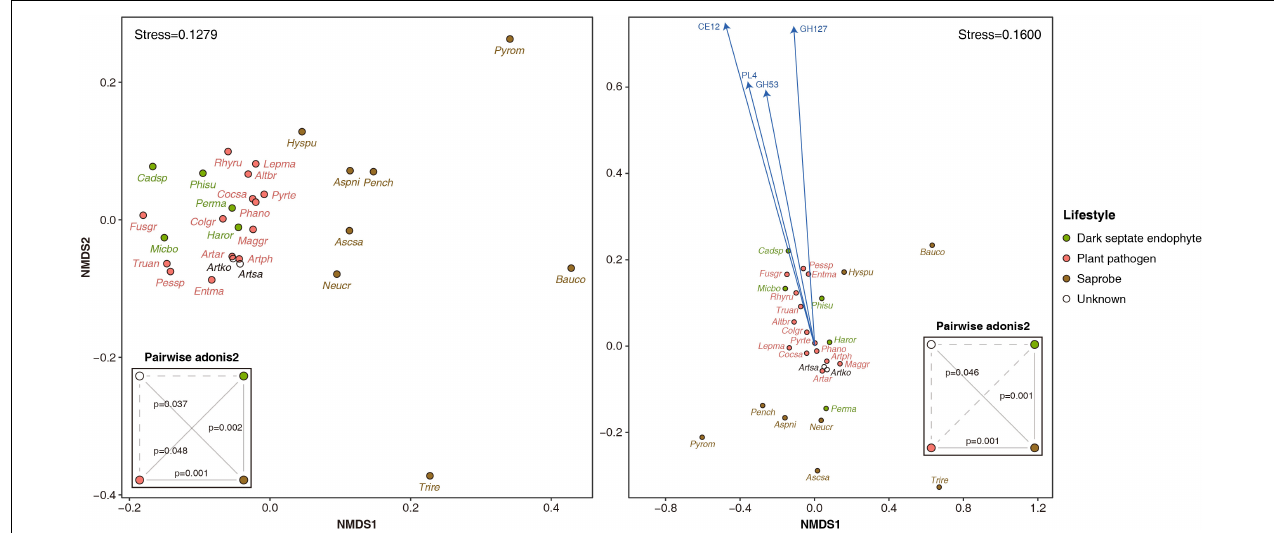
FIGURE 2 | Non-metric multidimensional scaling plot generated using profiles of carbohydrate active enzymes (CAZymes, left) and plant cell wall degrading enzymes (PCWDEs, right) of four Arthrinium spp. and other 25 ascomycetes with different lifestyles. Fitted variables are scaled by Pearson correlation coefficient ( p < 0.05). Dissimilarities between CAZyme and PCWDE profiles by lifestyle based on permutational multivariate analysis of variance were summarized in the small boxes titled pairwise adonis2. The solid and dotted lines in the pairwise adonis2 boxes indicate significant ( p < 0.05) and insignificant ( p > 0.05), respectively. Altbr, Alternaria brassicicola ; Artar, Arthrinium arundinis ; Artko, A. koreanum ; Artph, A. phaeospermum ; Artsa, A. saccharicola ; Ascsa, Ascocoryne sarcoides ; Aspni, Aspergillus niger ; Bauco, Baudoinia compniacensis ; Cadsp, Cadophora sp.; Cocsa, Cochliobolus sativus ; Colgr, Colletotrichum graminicola ; Entma, Entoleuca mammata ; Fusgr, Fusarium graminearum ; Haror, Harpophora oryzae ; Hyspu, Hysterium pulicare ; Lepma, Leptosphaeria maculans ; Maggr, Magnaporthe grisea ; Micbo, Microdochium bolleyi ; Neucr, Neurospora crassa ; Pench, Penicillium chrysogenum ; Perma, Periconia macrospinosa ; Pessp, Pestalotiopsis sp.; Phano, Phaeosphaeria nodorum ; Phisu, Phialocephala subalpina ; Pyrte, Pyrenophora teres ; Pyrom, Pyronema omphalodes ; Rhyru, Rhytidhysteron rufulum ; Trire, Trichoderma reesei ; Truan, Truncatella angustata .